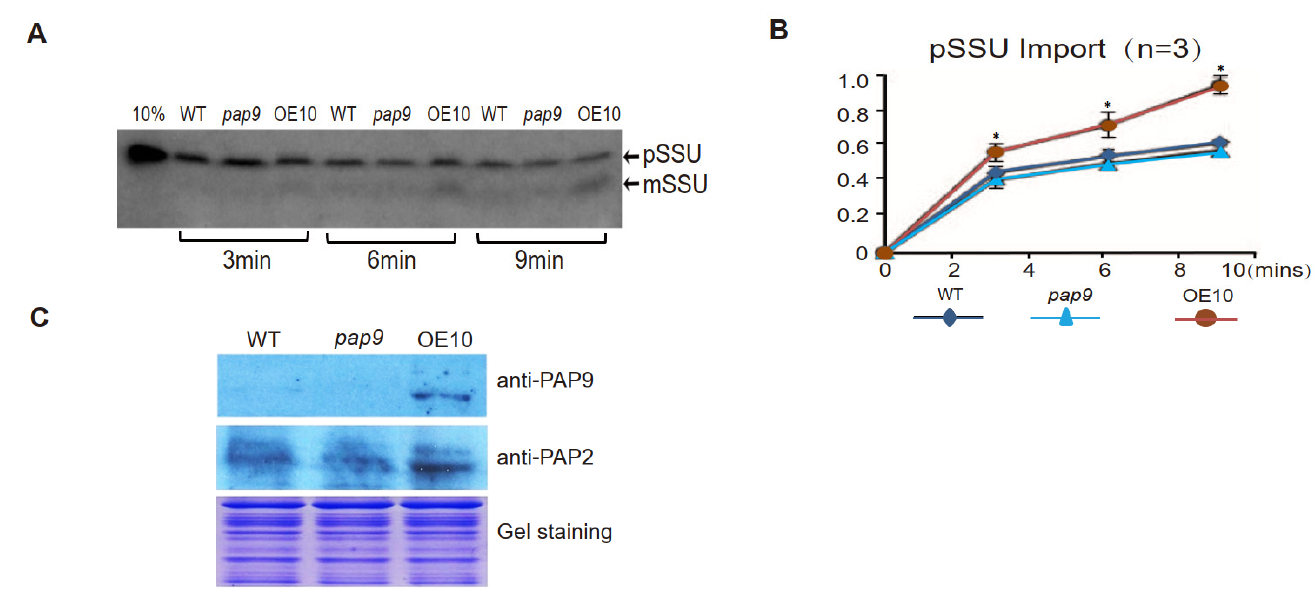
Figure 4. Import assay of [ 35 S]-labeled pSSU into chloroplasts. ( A ) Chloroplast import reaction contained chloroplasts equivalent to 16 μ g of chlorophyll and 6 μ L of wheat germ extract (WGE)-synthesized pSSU; 10% of labeled pSSU added to the import assay was used as a loading control. ( B ) Qualification of import assay in ( A ) by image J. The maximal amount of imported mSSU in the OE10 line at 9 min was taken as 1.0. The import rate of pSSU into OE10 chloroplasts was significantly higher than that of WT and pap9 chloroplasts (* p ≤ 0.05). Statistical difference was determined by one-way ANOVA followed by multiple comparisons using the Tukey method. ( C ) Chloroplasts isolated from WT, pap9 , and OE10 lines were separated by 12% ( v / v ) SDS-PAGE, and Western blotting was carried out using anti-AtPAP2 and anti-AtPAP9 antibodies.